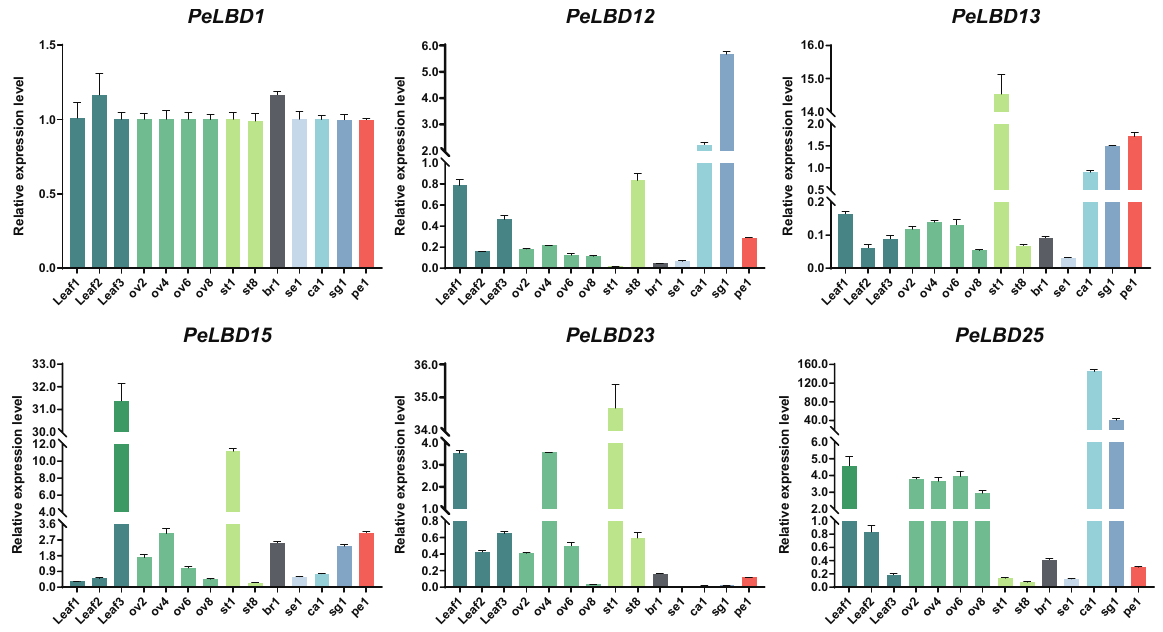
Figure 9. qRT-PCR analysis of six genes ( PeLBD1 , PeLBD12 , PeLBD13 , PeLBD15 , PeLBD23 and PeLBD25 ) in eight passion fruit tissues (leaf, ovule, bract, sepal, petal, corona filament, stamen and stigma). All experiments were performed independently at least three times. Error bars represent the standard deviation of three